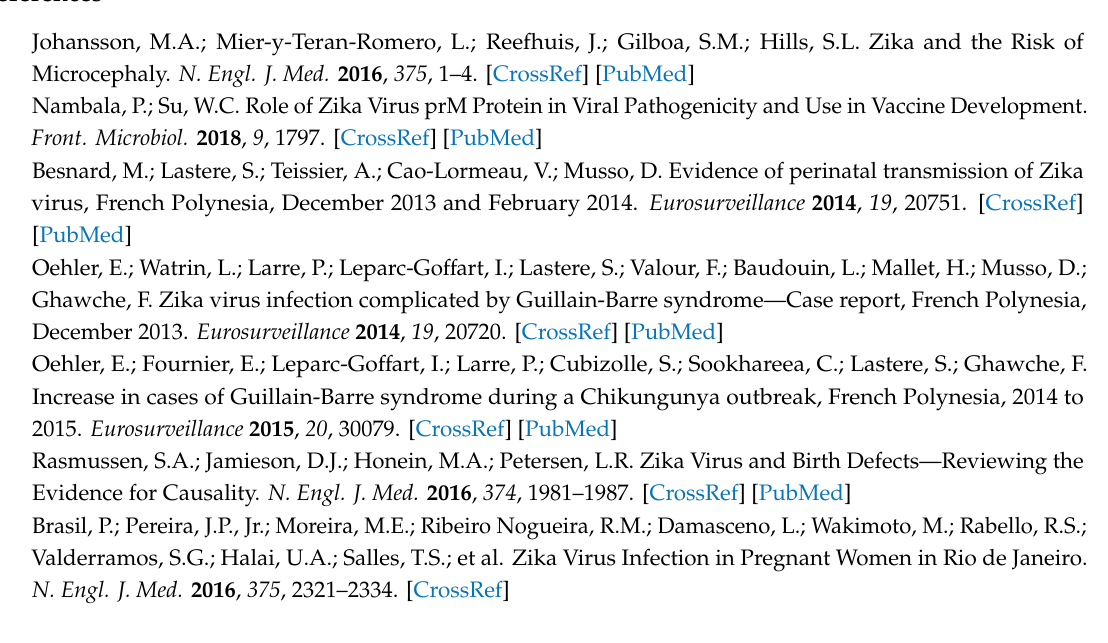
Figure S1: The e ff ect of replication of mRNA on the induction of type I interferon in IFN- β luciferase reporter mice, Figure S2: The e ff ect of di ff erent routes for mRNA delivery on the induction of type I interferon in IFN- β luciferase reporter mice, Table S1: A scoring system for weight loss and mobility impairment was used to determine survival rates following ZIKV challenge, Table S2: The significant di ff erences of Figure